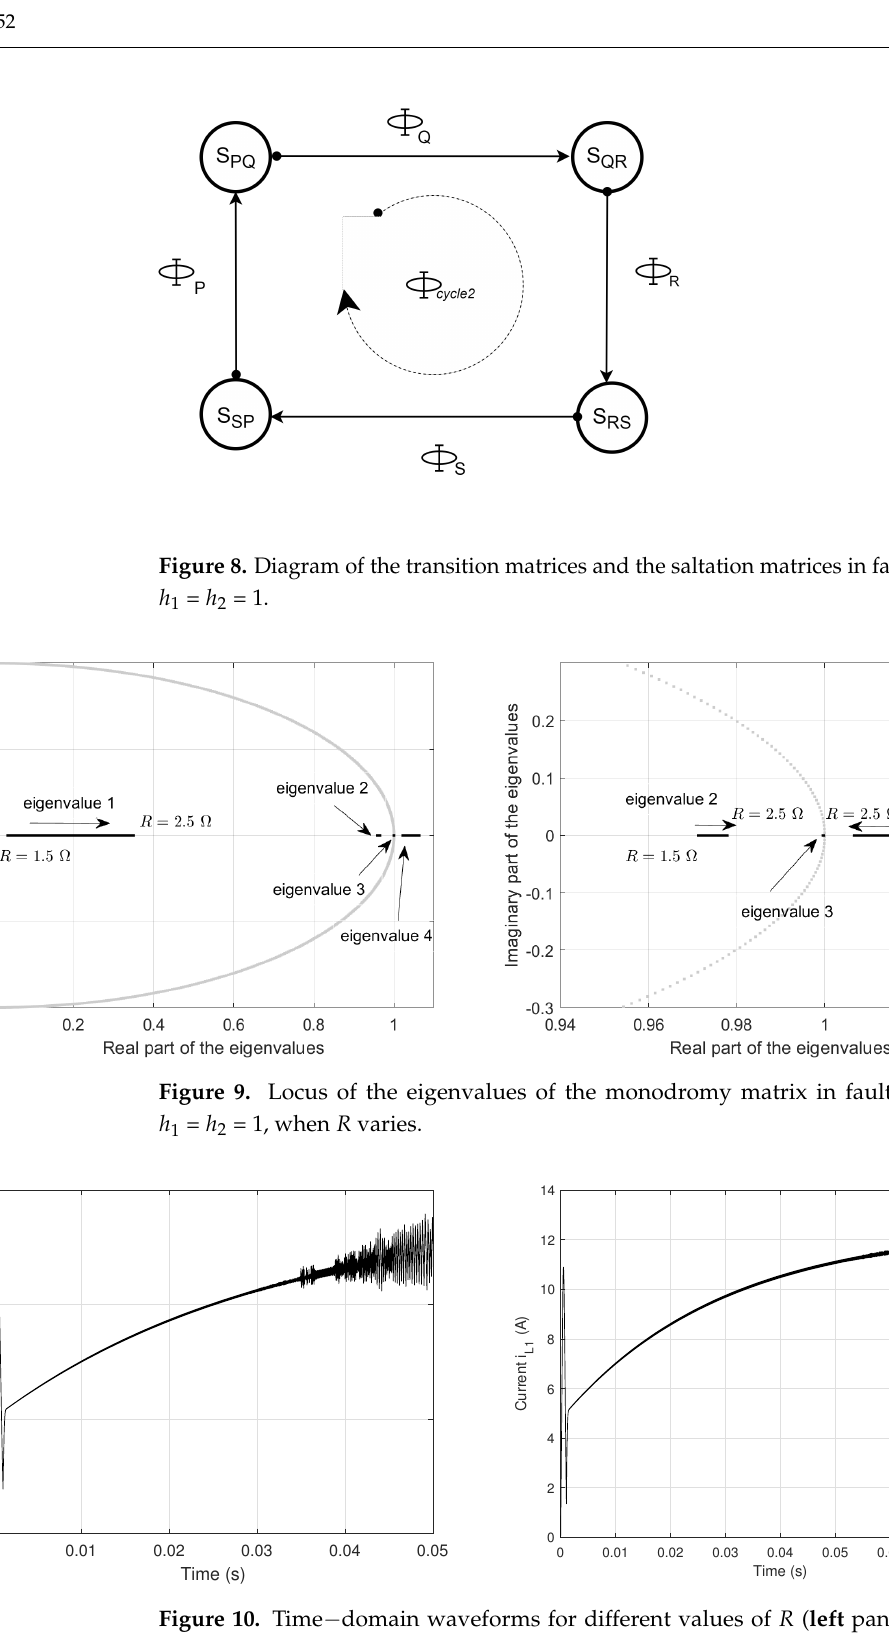
Figure 10. Time − domain waveforms for different values of R ( left panel R = 1.5 Ω , right panel R = 1.7 Ω ) and in faulty switching case h 1 = h 2 = 1, h 3 =